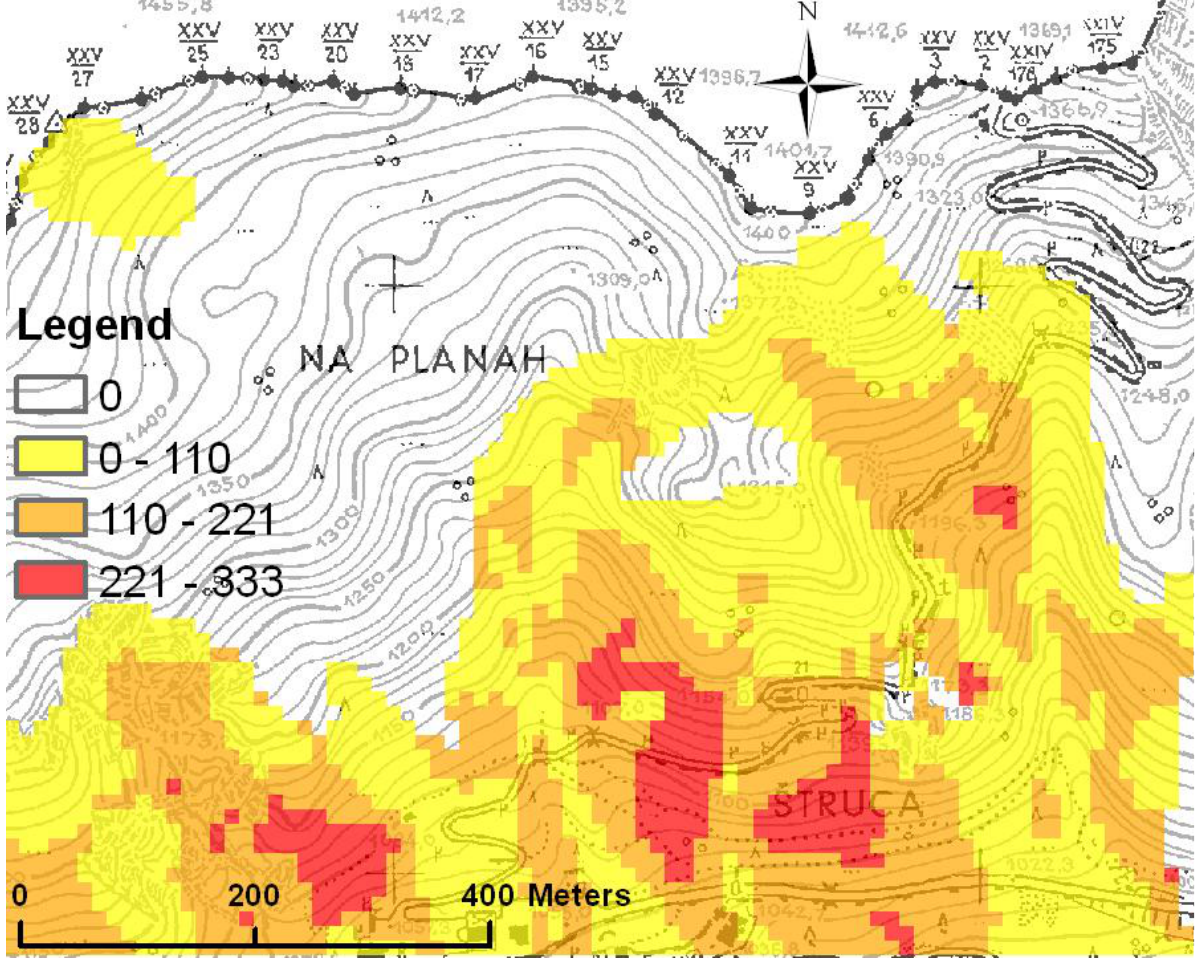
Figure 3. QGIS map of mean kinetic energy of falling rocks for non-forested slope scenario (in kilojoule